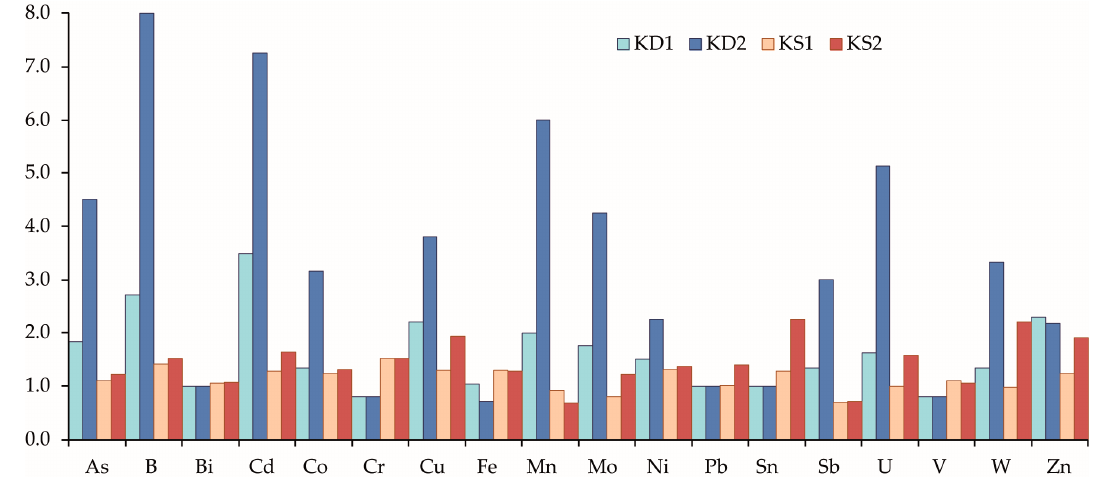
Figure 5. Concentration factors for dissolved and suspended metals in the Selenga basin in areas with anthropogenic impact (KD1 and KS1 respectively) and hot spots areas (KD2 and KS2) relative to background levels of the Selenga basin.